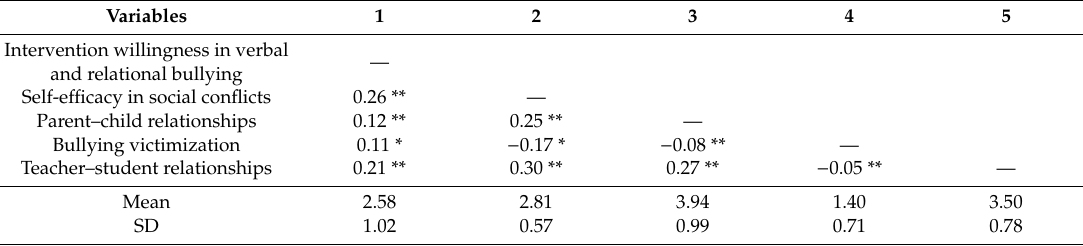
Table 2. Correlations and descriptive statistics among main study